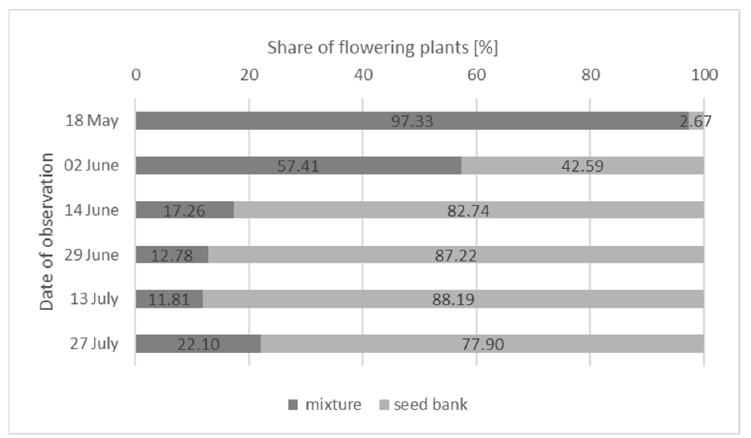
Figure 6. Share [%] of flowering plants in the flower strip in the second year (2022) after the establishment of the flower strip in relation to the date of observation.